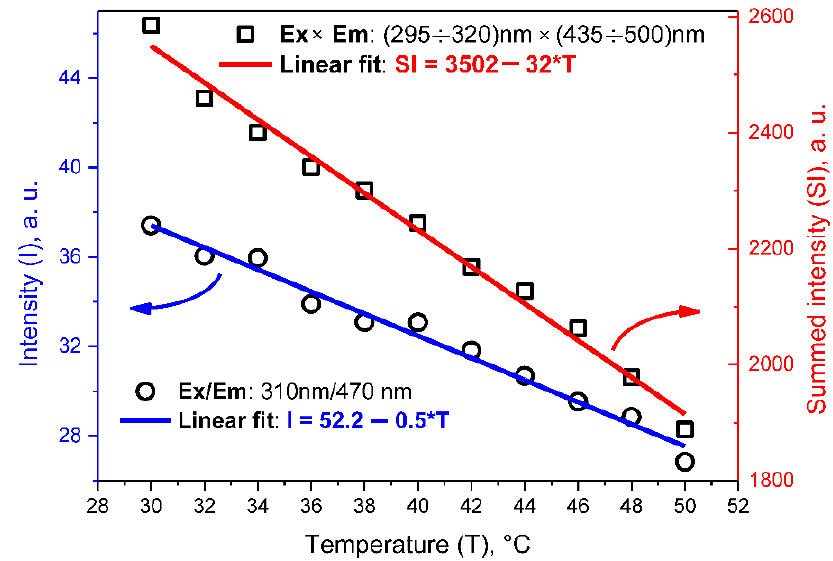
Figure 5. Temperature-dependent PL intensity of colloidal solutions of O, N-CDs in water (0.625 g/L). Black symbols—experimental points. Blue and red lines are linear fits of the experimental points corresponding, respectively, to a single spectral point Exc/Em: 310/470 nm and a spectral area: Exc × Em: (295–320) nm × (435–500) nm.